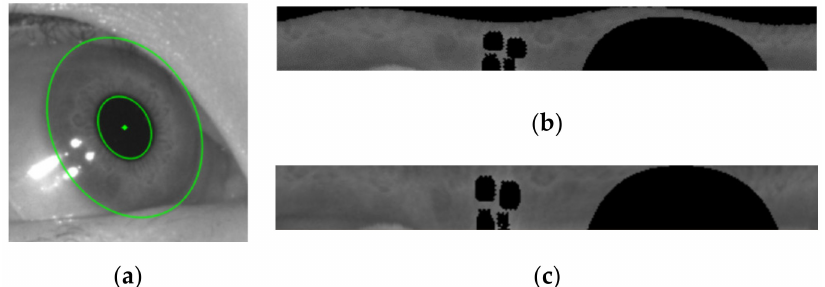
Figure 6. ( a ) Eye image taken at 25 ◦ horizontal eye position, with the detected iris to be unrolled; ( b ) the iris pattern directly unrolled from the current iris; ( c ) the iris pattern unrolled from current iris using the mapping relation. The black pixels represent the masked areas, including the upper eyelid, eyelashes and